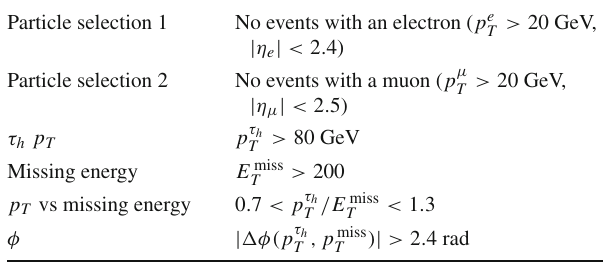
Table 4 Summary of the experimental cuts for the CMS τ h ν search